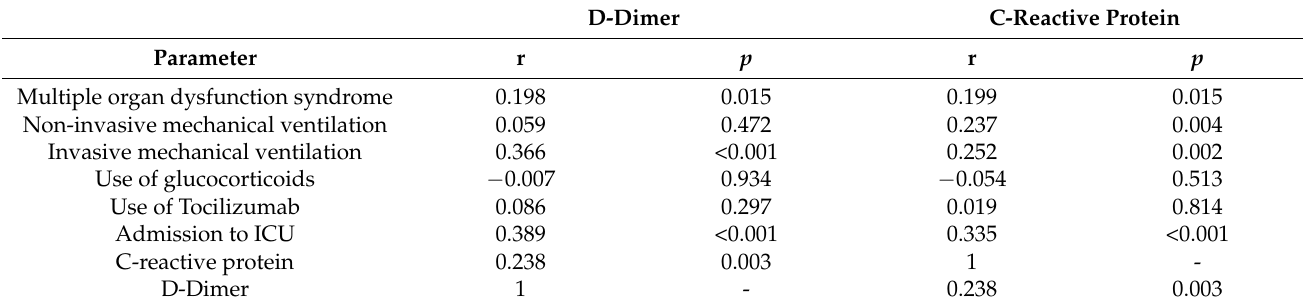
Table 6. Correlations of biomarkers with predictors of poor prognosis.